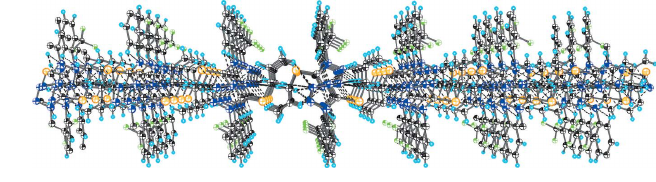
Figure 3 A C—H (cid:3)(cid:3)(cid:3) N-bonded layer in the structure of compound (I).